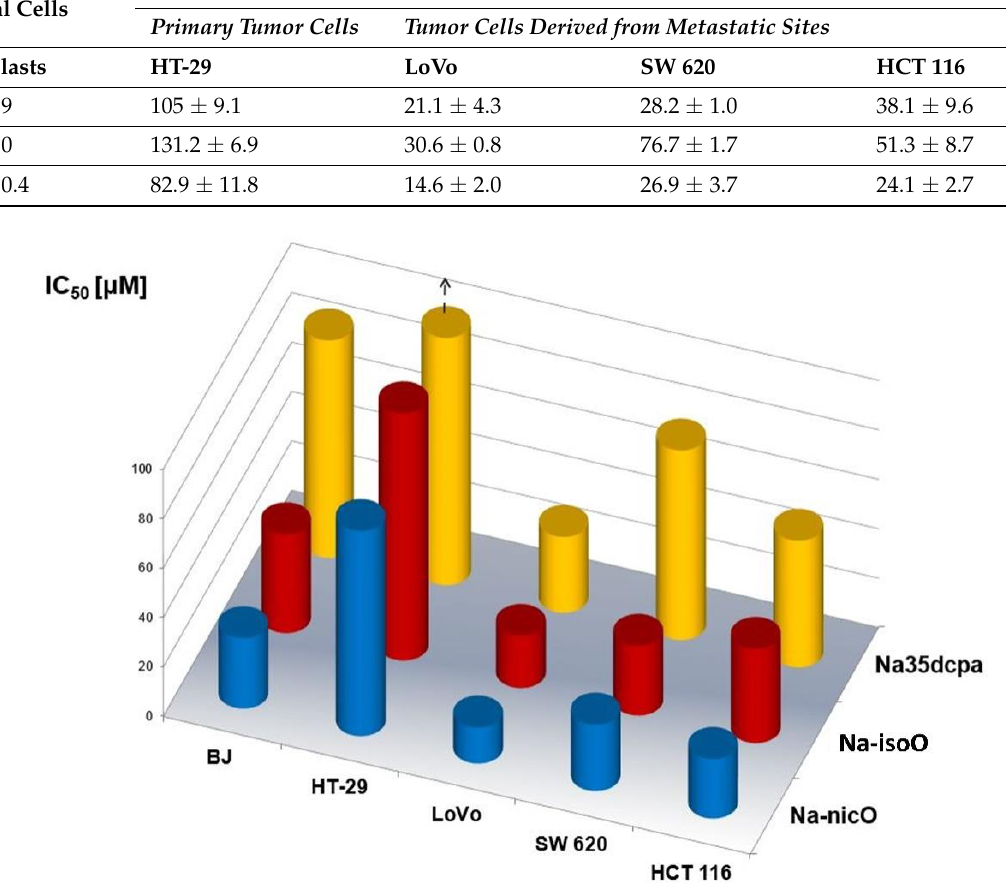
Figure 6. Comparative plot of IC50 values [ µ M] of Na-isoO , Na-35dcpa and Na-nicO against normal human fibroblasts (BJ) and human tumor cell lines (HT-29, LoVo, SW 620, HCT 116). Arrow up means higher value than presents on graph – see details on Table 4.